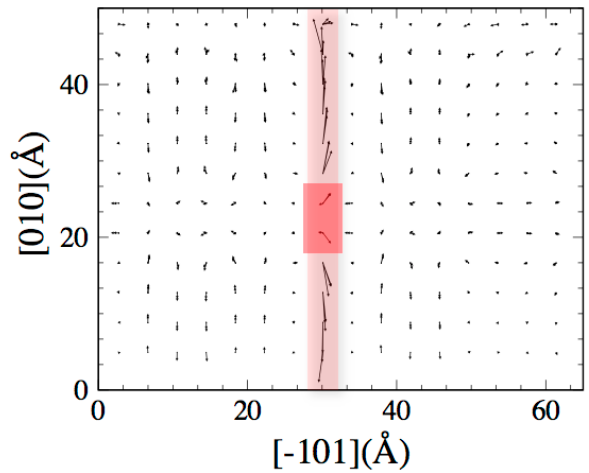
Figure 4. Vortex structure of Ti-displacements at an inversion point inside a twin wall in SrTiO 3 [18]. The view is perpendicular to the twin wall, which is pointing inside the plane of view. All Ti-displacements from the octahedral midpoints are small inside the two adjacent domains, but large inside the pink domain wall. The rotation of the displacement vectors inside the domain wall constitutes a Bloch wall [22] and is indicated in red.